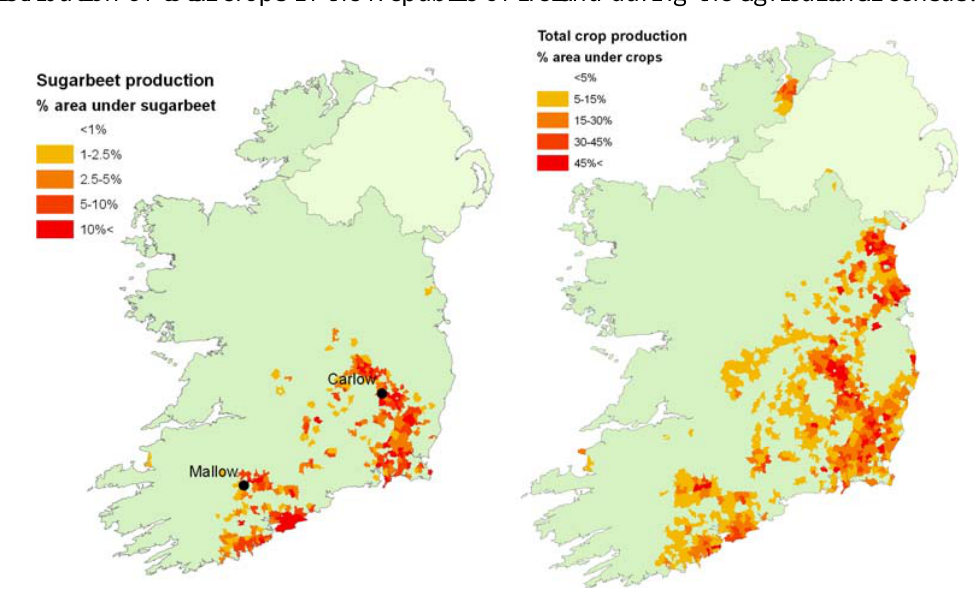
(b) distribution of total crops in the Republic of Ireland during the agricultural census.